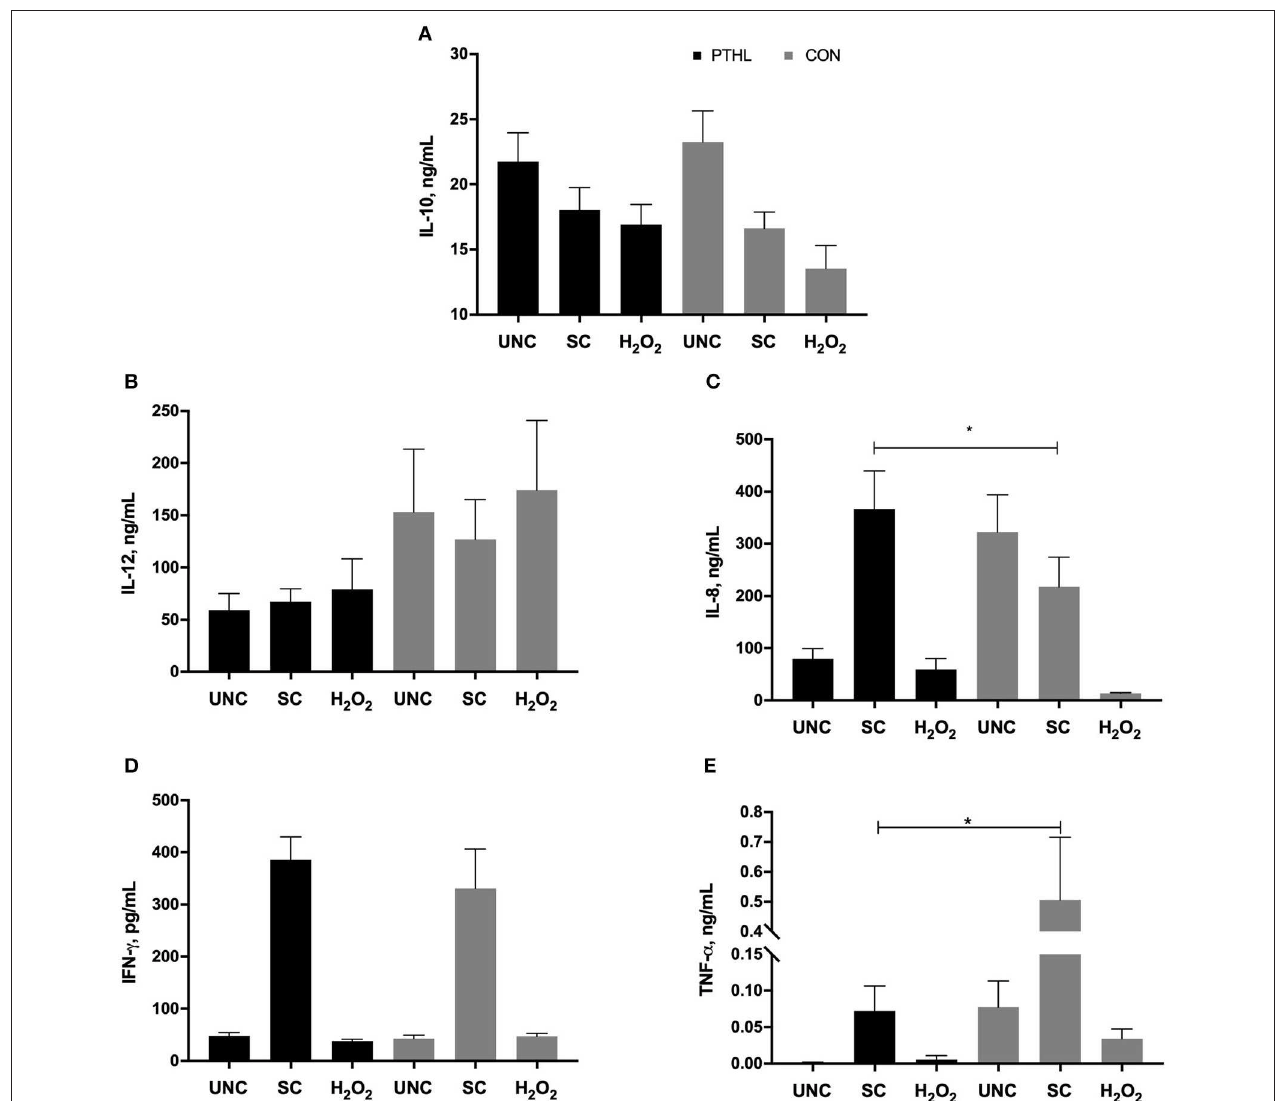
FIGURE 5 | Interleukin (IL)-10 (A) , IL-12 (B) , IL-8 (C) , interferon-(IFN)- γ , (D) , tumor necrosis factor (TNF)- α , and (E) secretion by PBMCs unstimulated (UNC) and stimulated with LPS and ConA (SC, 1 and 5 µ g/ml, respectively) and with 4mM of H 2 O 2 for 24h at 37 ◦ C/5% CO 2 . * P < 0.05 were considered significant among feeding